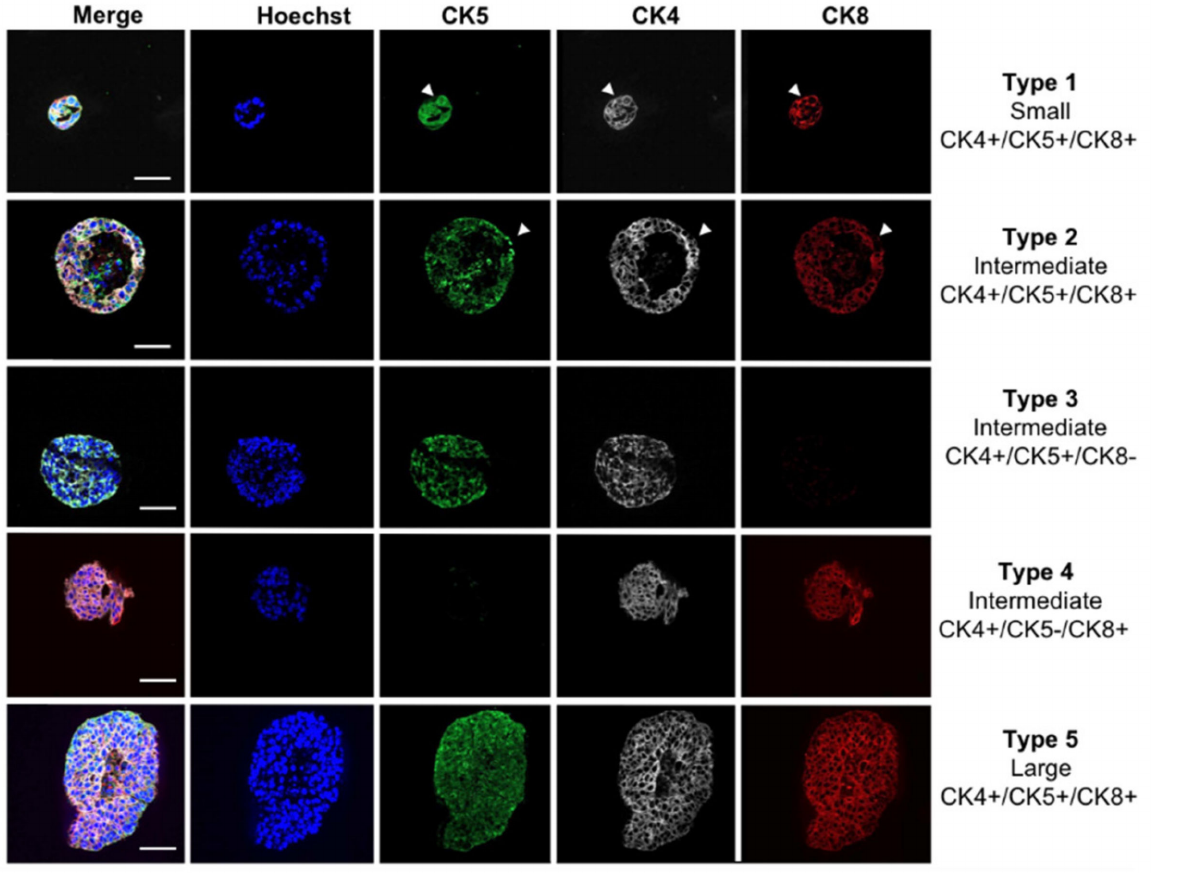
Figure 6. Immunofluorescence analysis of organoids generated from Pten-null mouse LSC med cells. Immunofluorescence staining of CK5 (basal marker, green), CK4 (LSCmed marker, white) and CK8 (luminal marker, red; note that CK8 is expressed in both LSCmed and secretory luminal cells) and organoid size identified five histological types of organoids that were observed in DHT/EGF- containing culture medium (see text for description). Arrowheads label double-positive cells in type 1 and type 2 organoids otherwise positive for the three CKs tested. Hoechst was used to stain nuclei. The scale bar represents 100 µ